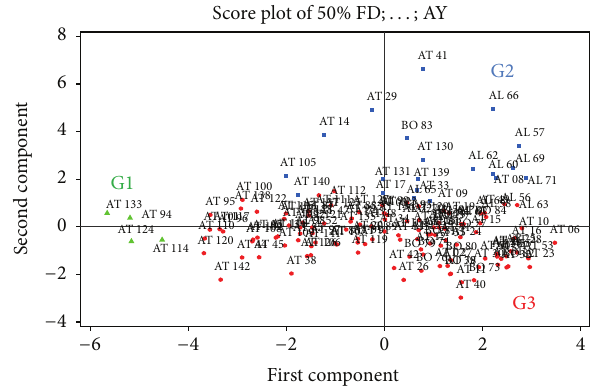
Figure 2: PCA grouping of the 142 Benin sorghum accessions using discriminatory quantitative